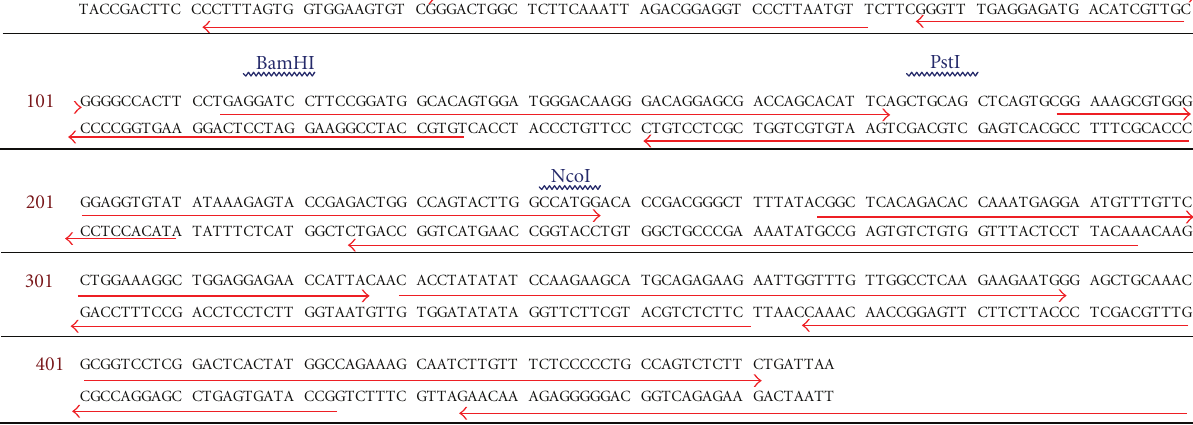
Figure 1: Oligonucleotides used to synthesize FGF1 . A total of 14 oligonucleotides, 50–70 nucleotides in length, collectively encoded both strands of the FGF1